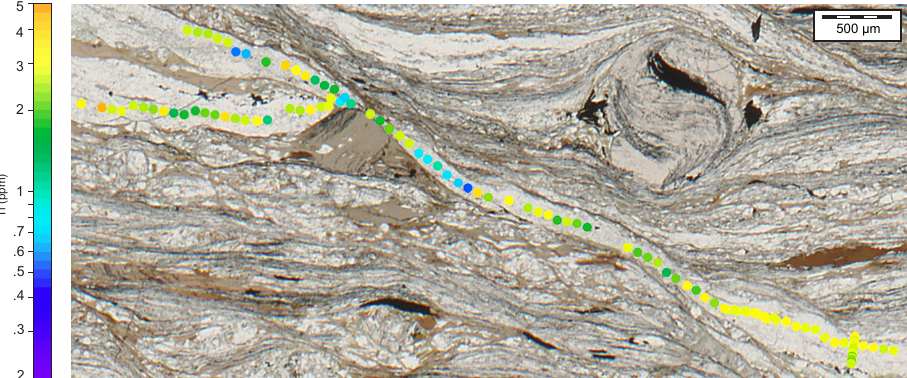
Figure 10. Photomicrograph of an older foliation (near-horizontal in this image) cut by a C (cid:48) shear band in a sample from Stony Creek. Ti concentrations are plotted from both inside and outside the shear band. Most of the lowest Ti measurements are from within the shear band, indicating some loss of Ti in quartz recrystallized during formation of the C (cid:48) layer. The foliations preserved in the garnet (upper right) and large biotite grain predate Alpine Fault